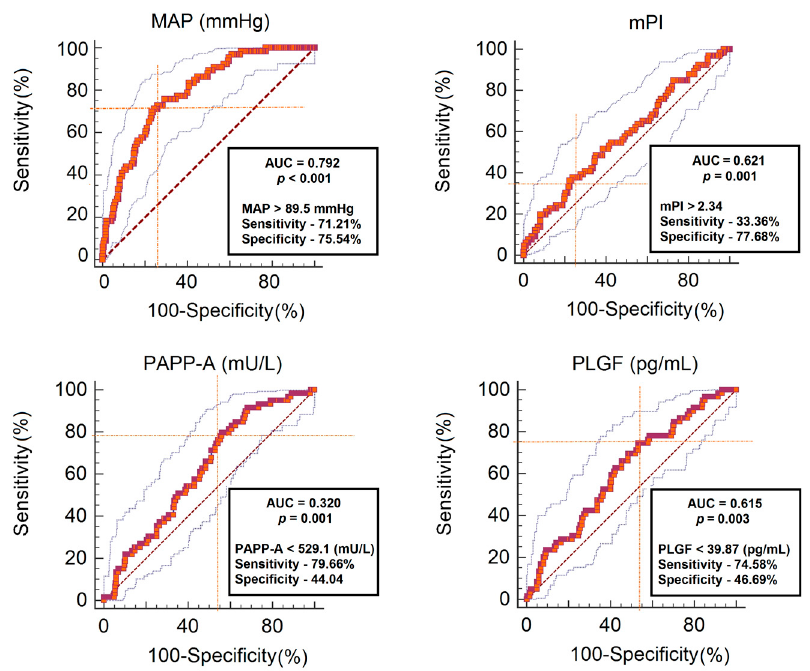
Figure 1. The best cut-off points of each biomarkers. PAPP-A—pregnancy-associated plasma protein-A; PlGF—maternal serum placental growth factor; MAP—mean arterial pressure; mPI—mean pulsatility index of uterine artery; AUC—Area Under a receiver-operating characteristics